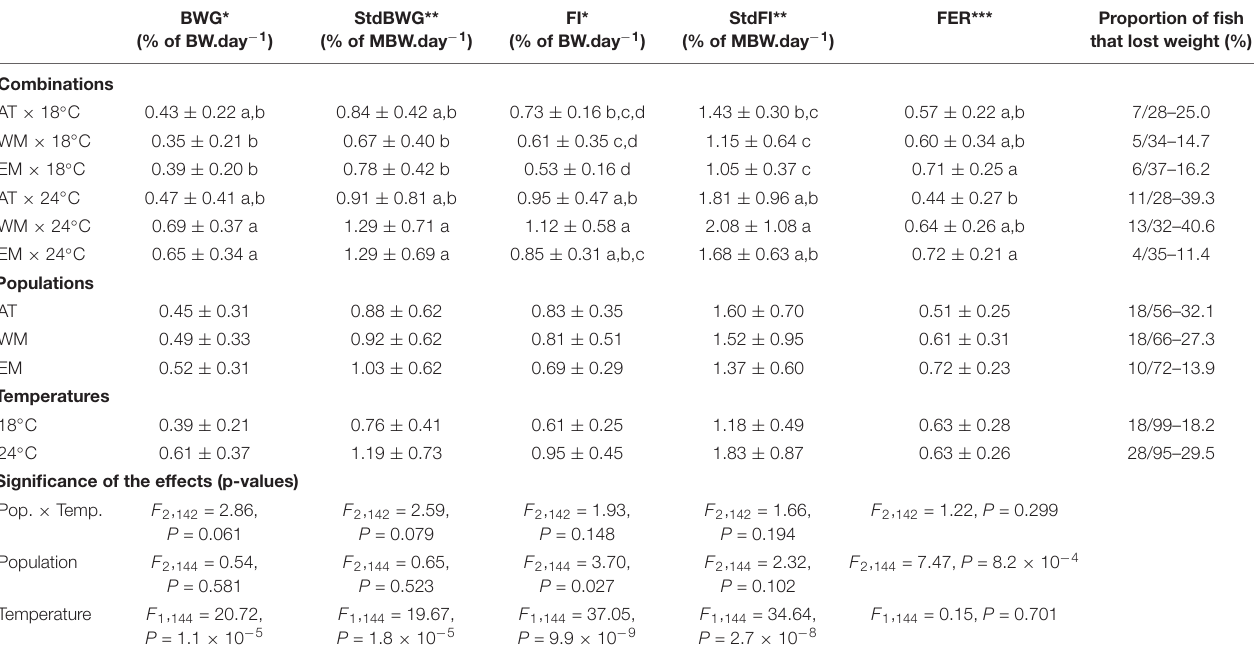
TABLE 1 | Mean ± standard deviation of body weight gain (BWG), body weight gain standardized to metabolic body weight (StdBWG), feed intake (FI), feed intake standardized to metabolic body weight (StdFI) and feed efficiency ratio (FER) recorded for 22 days with fish fed at 100% of ad libitum feeding